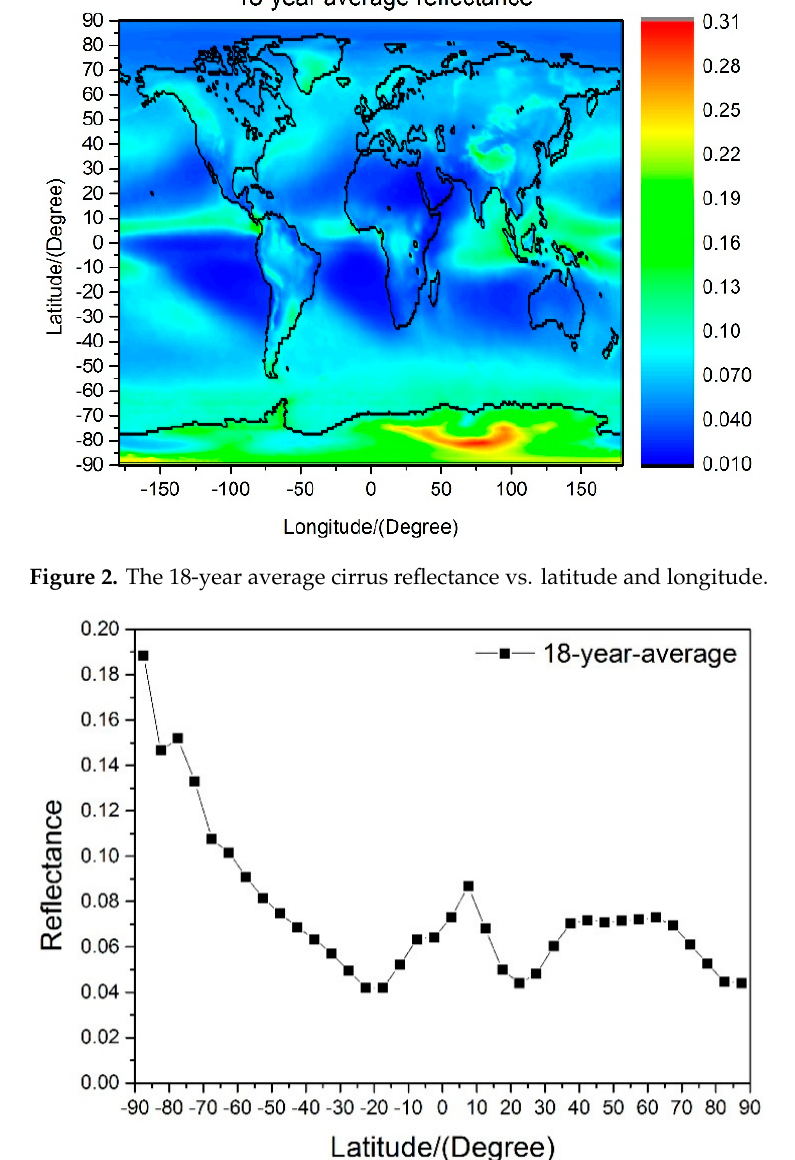
Figure 3. The global average of cirrus reflectance.